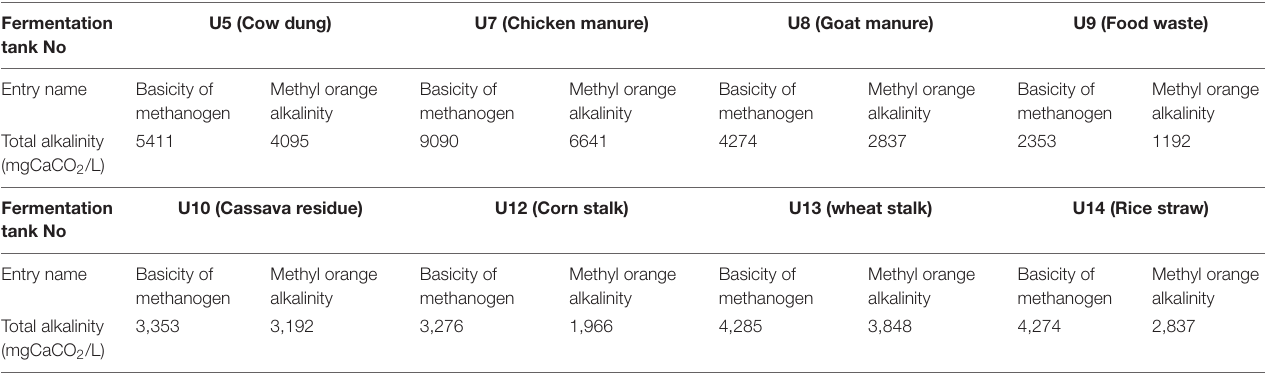
TABLE 3 | Daily average alkalinity value of each fermenter at the later stage of fermentation. Fermentation tank No